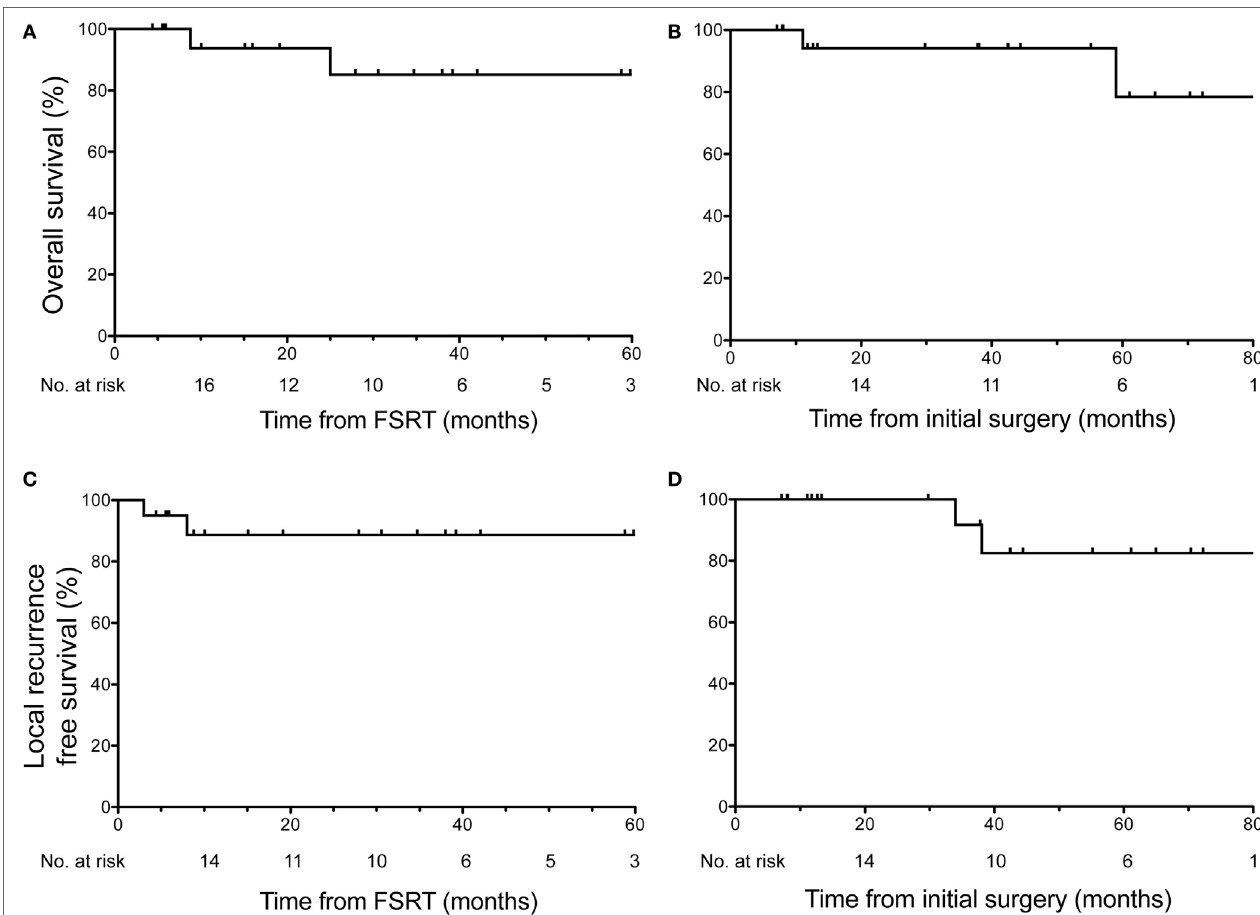
FigUre 1 | Overall survival (OS) and local recurrence free survival in all patients. OS across all 20 patients shown relative to (a) time of fractionated stereotactic radiotherapy (FSRT) and (b) time of initial surgery or biopsy. Two deaths were reported during follow-up, the first 9 months after FSRT (11 months after surgery) for recurrent clival chordoma and the second 25 months after FSRT (59 months after surgery) in a patient with recurrent sacral chordoma. Local recurrence-free survival across all 20 patients shown relative to (c) time of FSRT and (D) time of initial surgery or biopsy revealed two local recurrences in the follow-up period. Median follow-up from time of FSRT was 28 months, and median follow-up from time of initial surgery/biopsy was 40